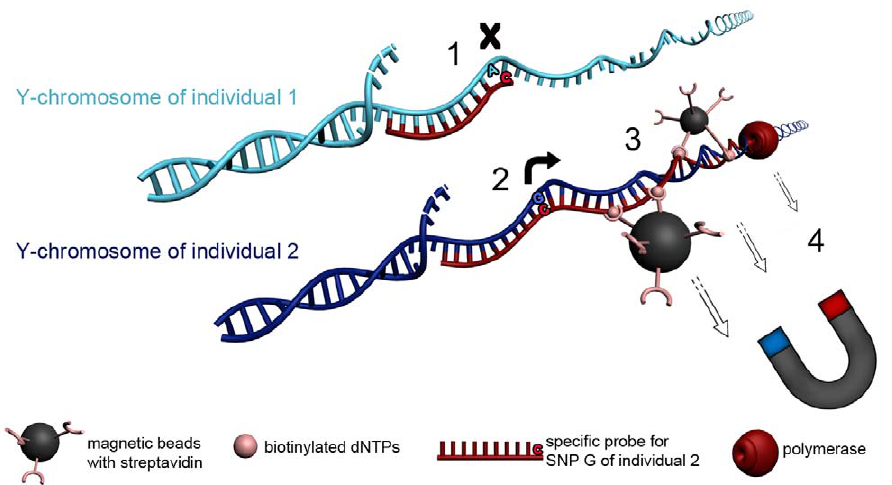
Figure 1. Schematic illustration of HSE for the separation of male DNA mixtures. A male DNA mixture is shown by the presents of two different Y-chromosomes from individual 1 (light-blue) and individual 2 (dark-blue) which differ in a theoretical SNP A/G. The principal of HSE is than shown by the separation of a Y-chromosomal fragment of individual 2 by the use of a probe specific to the SNP allele G. (1) HSE-probe shows 3 9 terminal mismatch for individual 1, therefore no extension occurs. (2) Probe matches completely at Y-chromosome of individual 2 and can be extended. (3) During extension reaction the polymerase incorporates biotinylated dNTPs. Streptavidin coated magnetic beads bind to biotin labeled DNA. (4) The DNA-biotin-streptavidin complex can be captured by the use of a magnetic